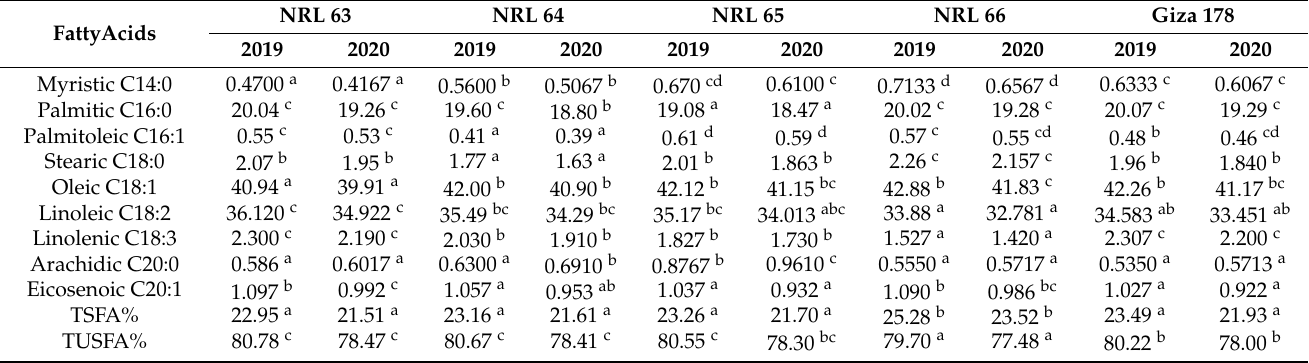
Table 7. Mean performances for fatty acids profile of stabilized rice bran oil of the studied genotypes during the 2019 and 2020 growing